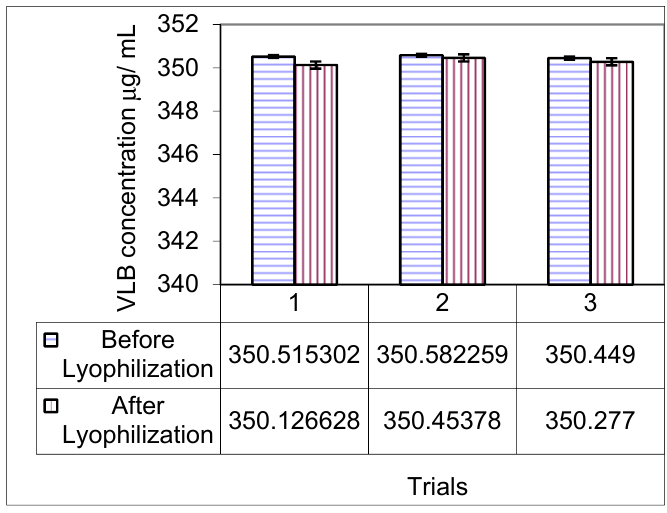
Figure 12. The difference in concentration of VLB incorporated with micelles made of Y-shaped polymer before and after lyophilization (350 µg VLB/5 mg